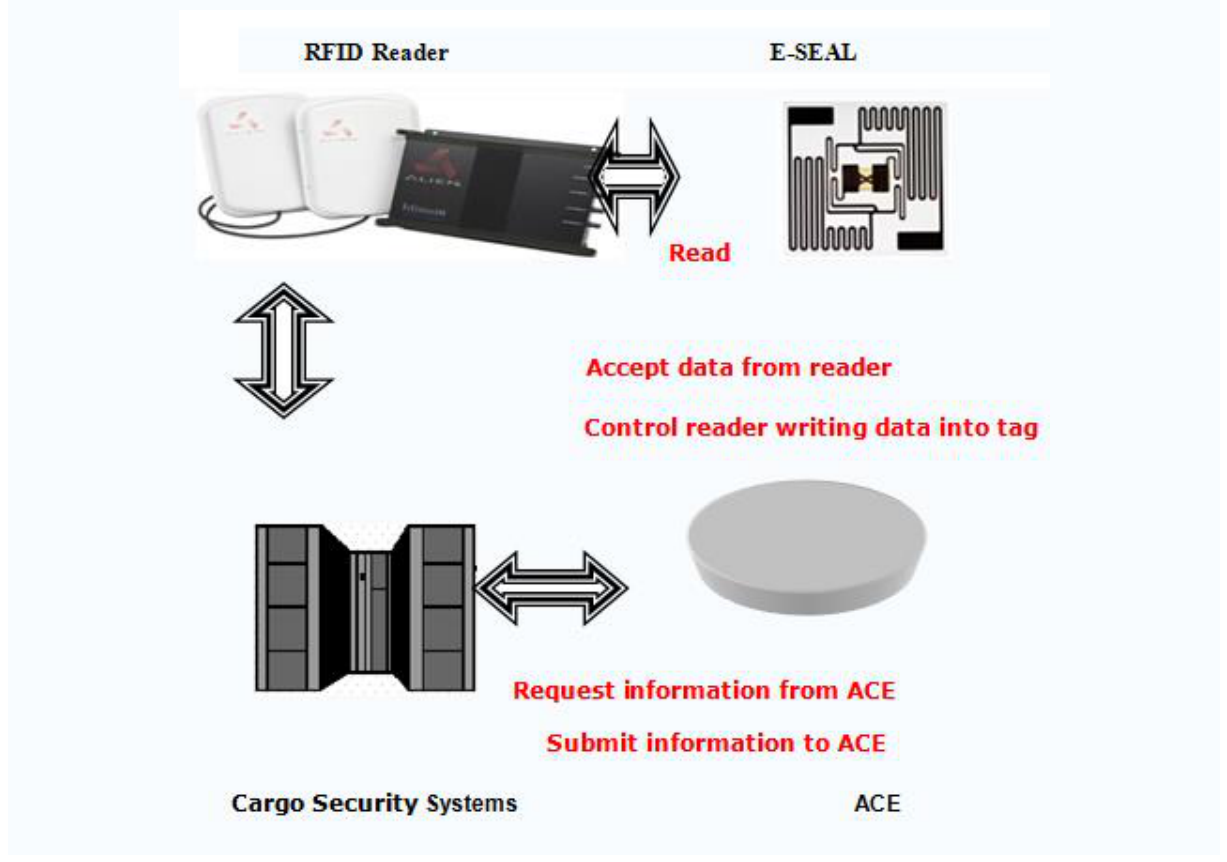
Figure 6. Cargo Security System